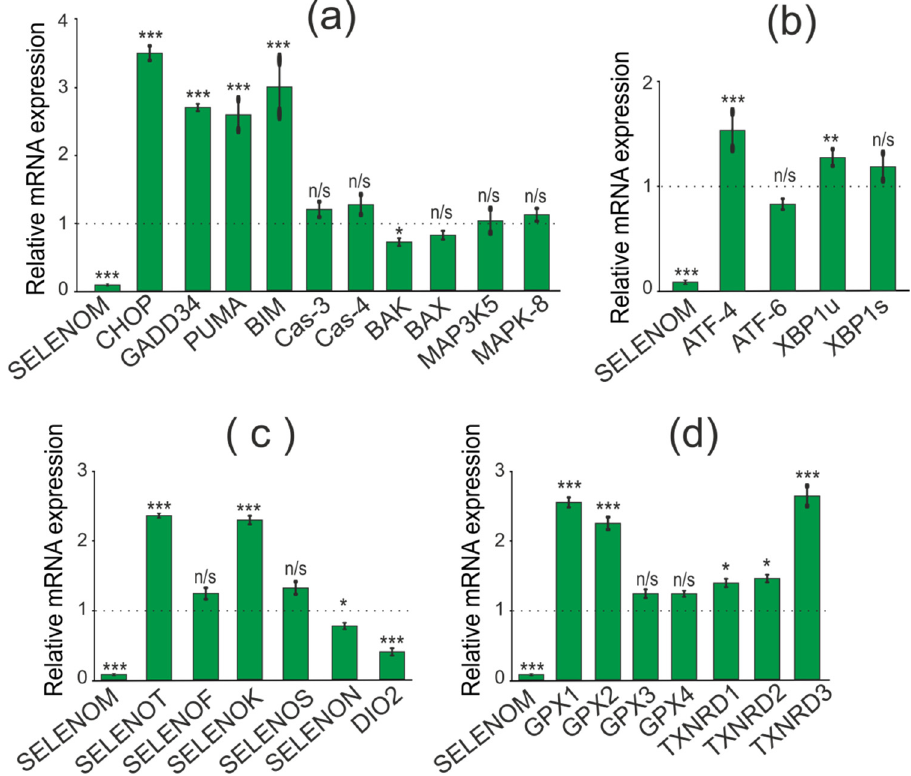
Figure 5. Comparative analysis of mRNA expression patterns of various genes under SELENOM-KD and without SELENOM-KD conditions, obtained using real-time PCR. ( a ) mRNA expression of pro-apoptotic genes; ( b ) mRNA expression of markers of three UPR signaling pathways; ( c ) mRNA expression of ER resident selenoproteins; ( d ) mRNA expression of selenium-containing glutathione peroxidases and thioredoxin reductases. Comparison of experimental groups regarding control, indicated as dash line (1): n/s—data not significant ( p > 0.05), * p < 0.05, ** p < 0.01 and *** p < 0.001.